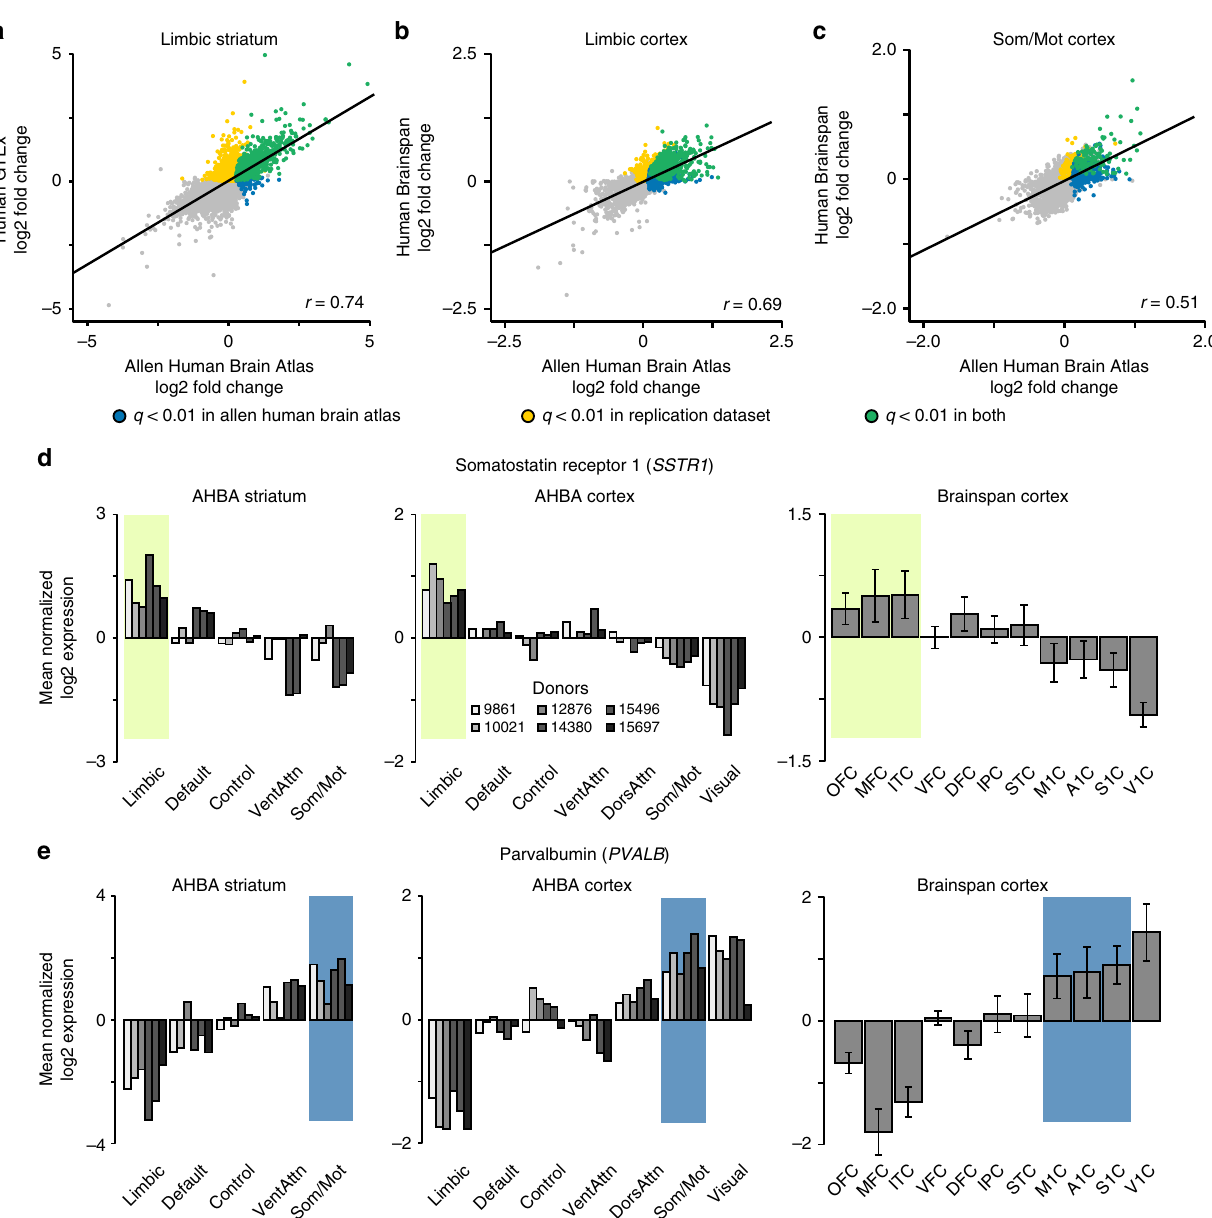
Fig. 6 Differential expression across cortical and striatal networks is consistent within independent human datasets. a RNAseq data from 111 putamen, 130 NAcc, and 144 caudate tissue samples were obtained from the Genotype-Tissue Expression (GTEx) project. GTEx samples from the NAcc correspond to the limbic aspect of striatum in the AHBA dataset. Across all genes, differential expression (i.e., log2 fold change) in GTEx NAcc, relative to caudate and putamen, co-varied with differential expression in AHBA limbic striatum ( r = 0.74, p ≤ 0.001). b RNAseq data for 8 adult donors sampling 11 cortical brain regions were obtained from the Brainspan atlas. Across all genes, fold change in Brainspan limbic cortex (i.e., OFC, ACC, ITC) correlated with fold change in the AHBA limbic cortex ( r = 0.69, p ≤ 0.001). c Gene-wise fold change in Brainspan somato/motor cortex (i.e., M1C, S1C, A1C) correlated with fold change in the AHBA somato/motor cortex, r = 0.51, p ≤ 0.001. Gray denotes genes that are not positively differentially expressed. d Somatostatin